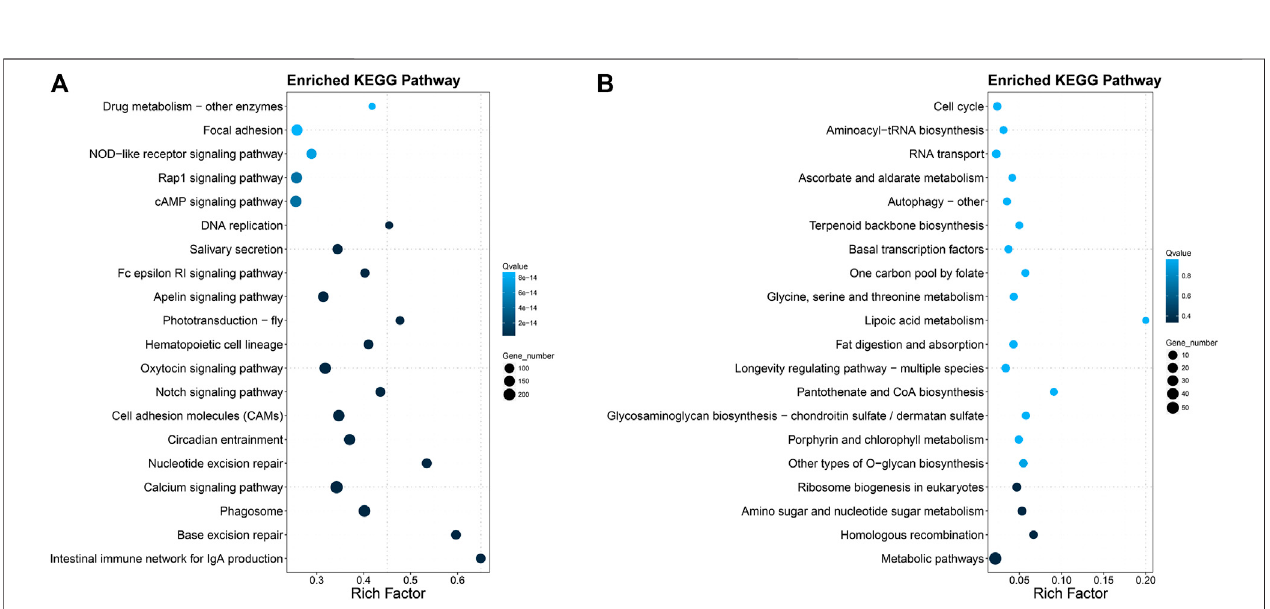
FIGURE 3 | KEGG pathway enrichments in spiny head croaker. (A) Pathway enrichments of expanded gene families; (B) pathway enrichments of positive selected genes.